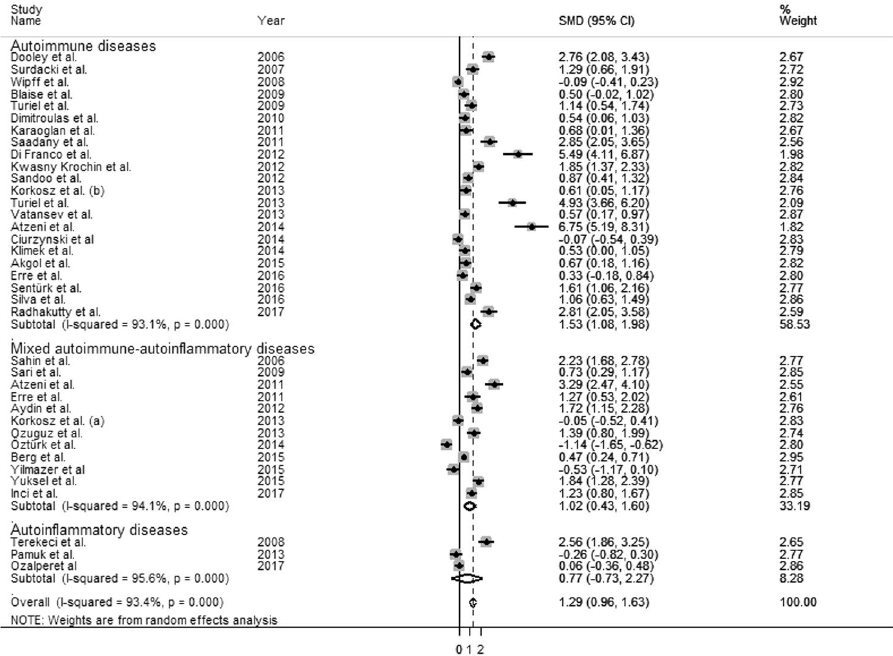
Figure 6. Forest plot depicting the standard mean (SMD) of dimethylarginine (ADMA) concentrations in autoimmune (Systemic lupus erythematosus-SLE, Systemic sclerosis-SS, Rheumatoid arthritis-RA, and Sjogren’s syndrome-SSj) vs mixed autoimmune-autoinflammatory (Behcet’s disease-BD, psoriatic arthritis-PsA, and ankylosing spondylitis-AS) vs autoinflammatory (Familial Mediterranean fever